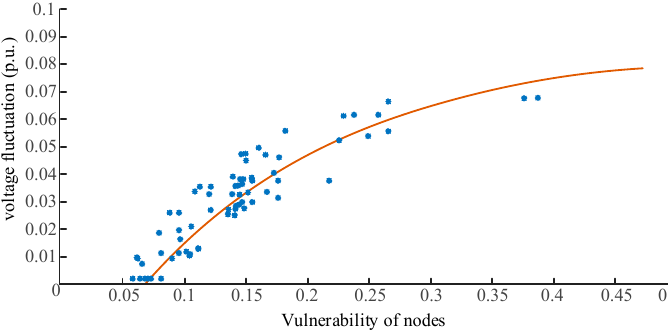
Figure 5. Correlation scatter diagram between voltage fluctuation and node vulnerability.